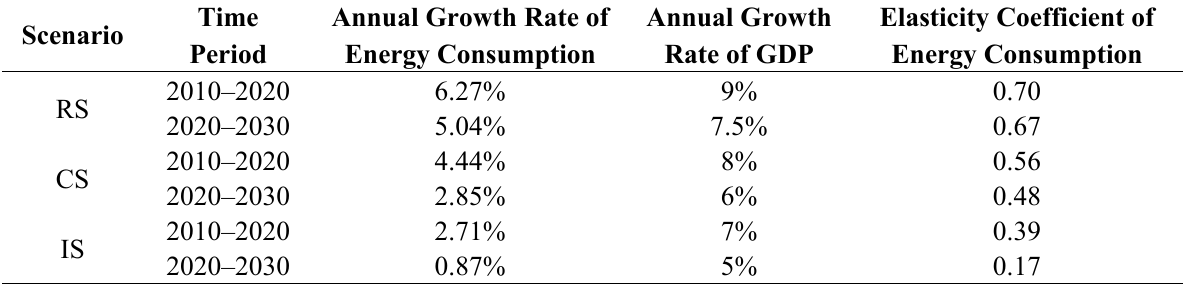
Table 5. Elasticity coefficient of energy consumption for the RS, CS, and